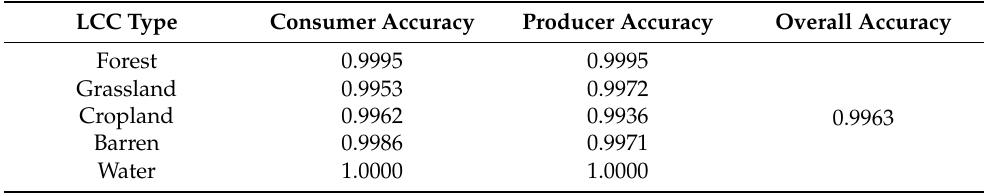
Table 1. Consumer, producer and overall accuracies of land cover classification using Landsat images within the Google Earth Engine. The accuracy was averaged from all provinces and